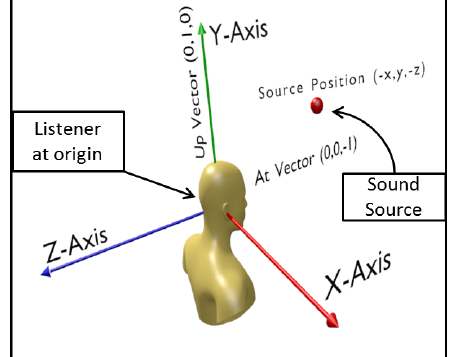
Figure 7: A virtual listener and a sound source are shown